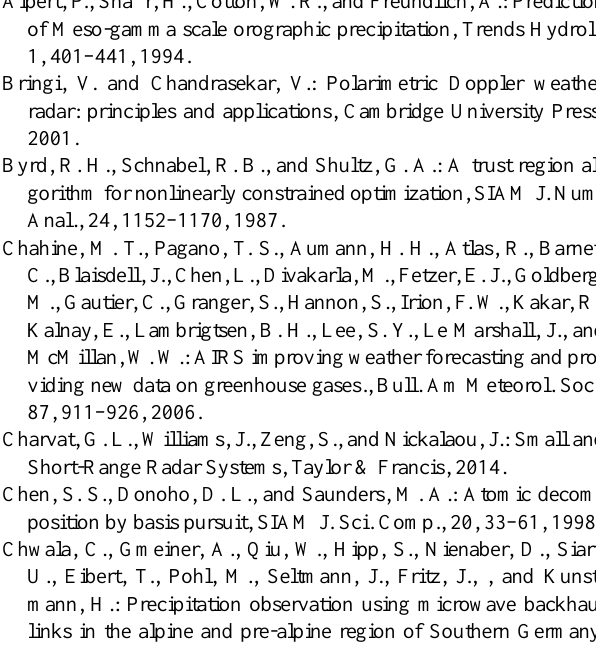
Table 1. Spatial correlation of all methods for all time steps.